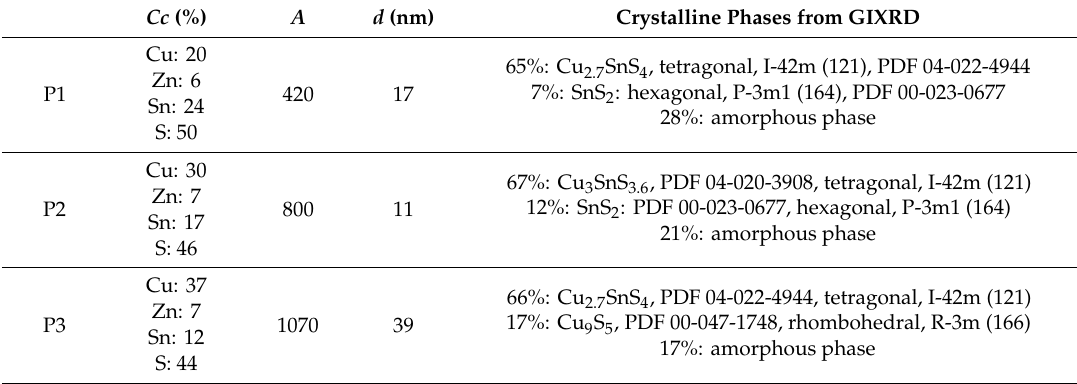
Table 3. The majority and minority phases after the sulfurization annealing of the Cu 2 S–ZnS–SnS 2 samples. The PDF file number, the lattice system, and the space group were indicated for each crystalline phase. In addition, the sample chemical composition ( Cc ), the area of the peak at 2 θ ~ 28.540 ◦ ( A ) and the average size of the crystallites of the majority phase ( d ) computed from this peak are